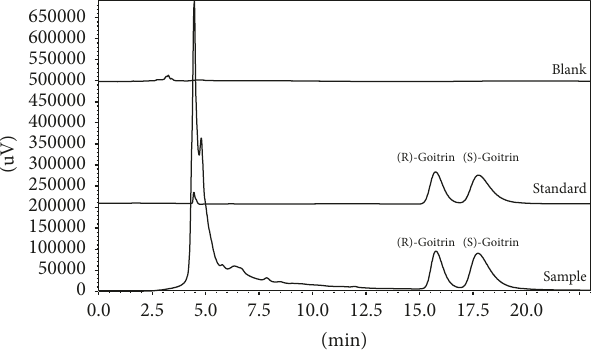
Figure 4: Typical chromatograms obtained for the blank reference, standard solution containing racemic (R, S)-goitrin, and commer- cial granules. Experimental conditions: S-Chiral A column (4.6mm × 250 mm, 5 𝜇 m), methanol/water (30: 70, v/v), 0.4 mL/min, 35 ∘ C, 245 nm, and injection volume of 10 𝜇